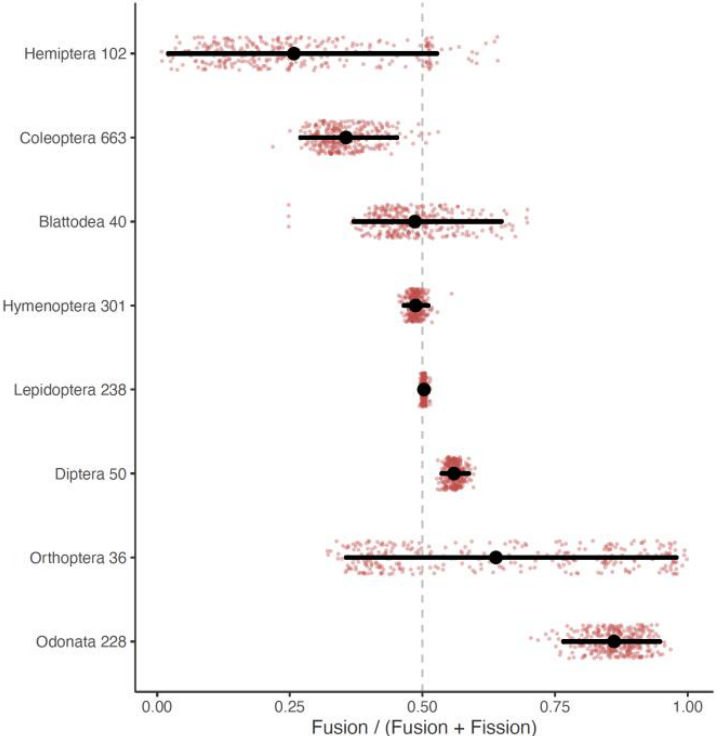
Figure 3. Normalized rates ratio for chromosome evolution. Each row of the plot represents an order; the number after the order name indicates the number of tips included in the analysis. The horizontal axis indicates the normalized rates ratio. The black line indicates the credible interval for the rates ratio and the mean is indicated by the larger black circle.